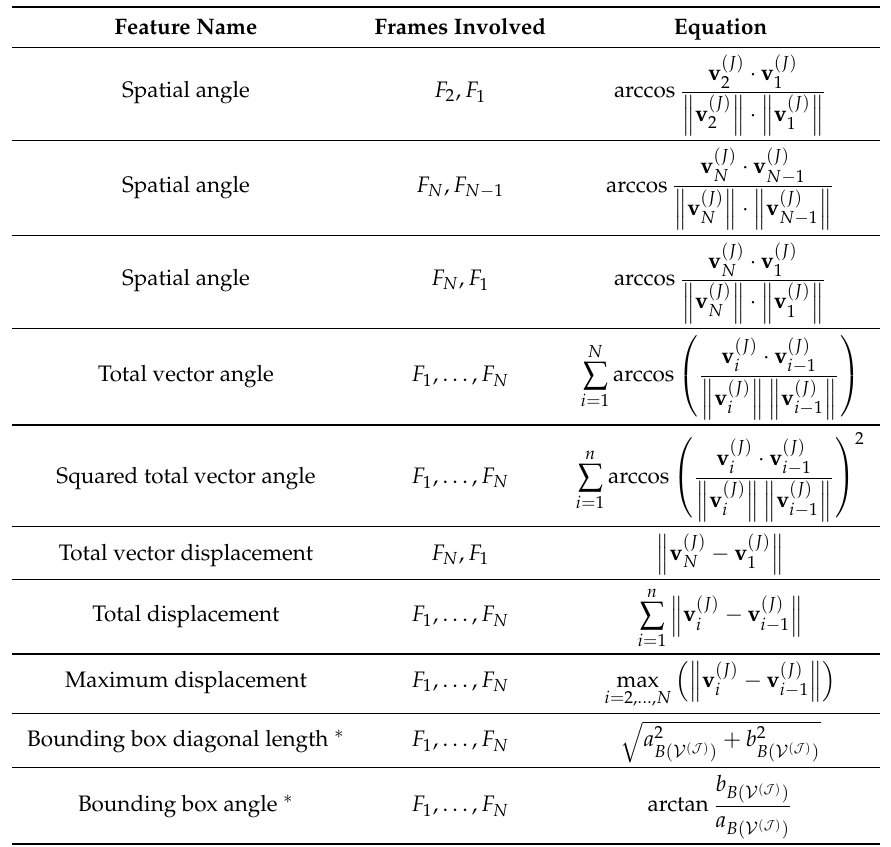
Table 1. Proposed features, extracted from the skeletal joints (features marked with ∗ , are calculated using only HandLeft and/or HandRight).